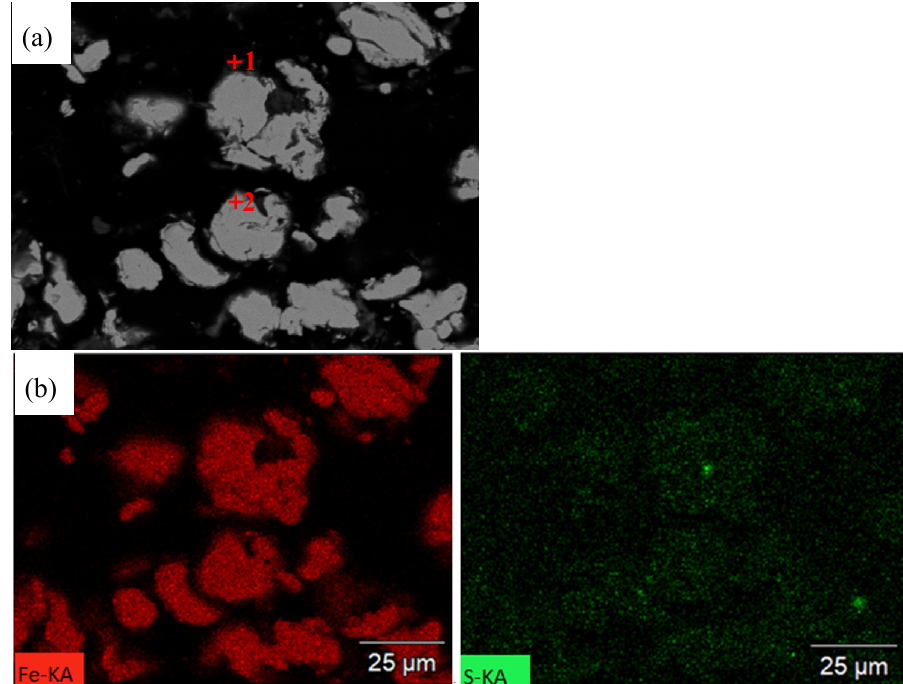
Figure 13. SEM-EDS images and elemental surface scanning images of reduced iron products with 15 wt% CaO. ( a ) SEM-EDS images, “+” refer to analyzed point by EDS, numbers refer to composition data in Table 8; ( b ) elemental surface scanning images of ( a ). Table 8. Chemical composition of points indicated in Figure 13 (wt%).